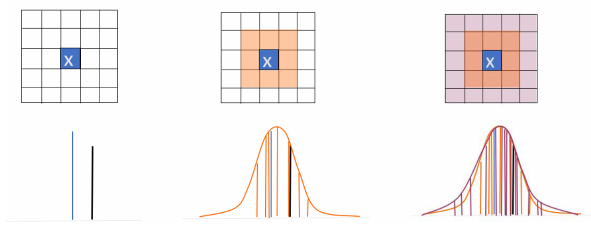
Figure 4. Example of how different forecast neighbourhood sizes would contribute to the generation of a probability density function around an observation (denoted by x). The larger the neighbour- hood, the better described the pdf, though potentially at the expense of larger spread. If a forecast point is invalid within the forecast neighbourhood, that site is rejected from the calculations for that neighbourhood